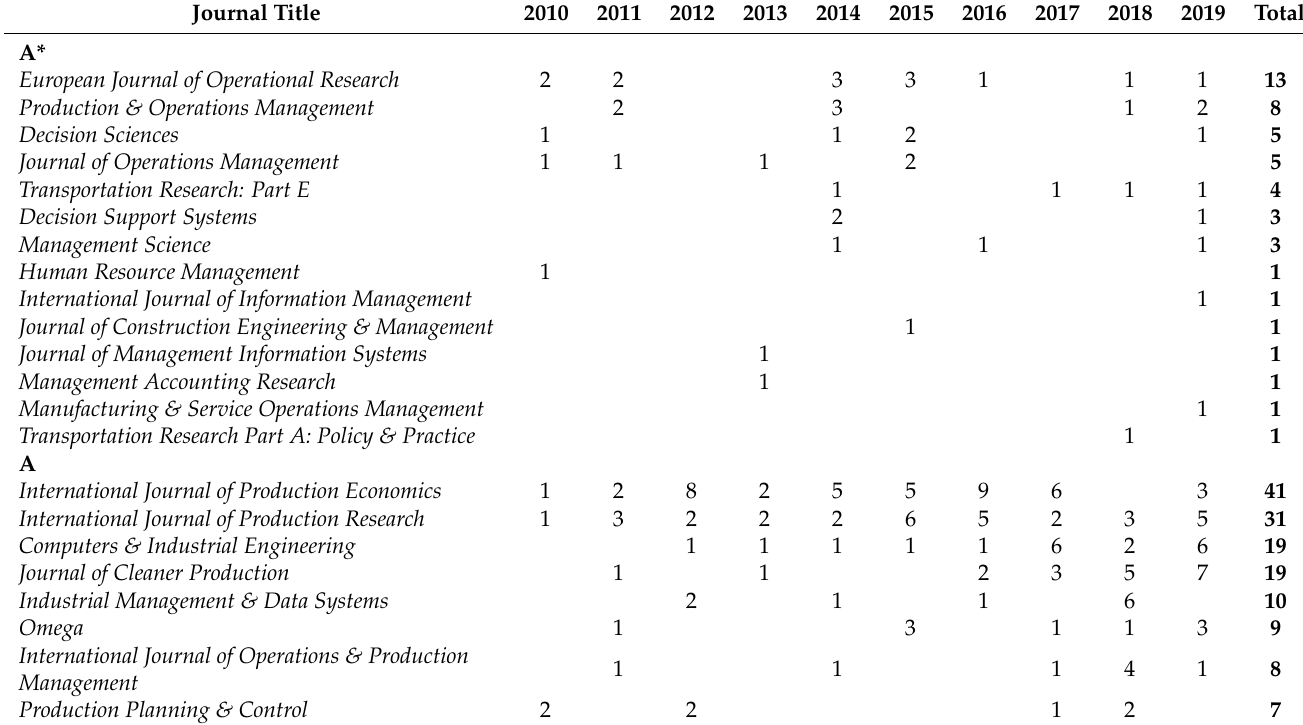
Table A1. Research Articles Published in ABDC Journal by